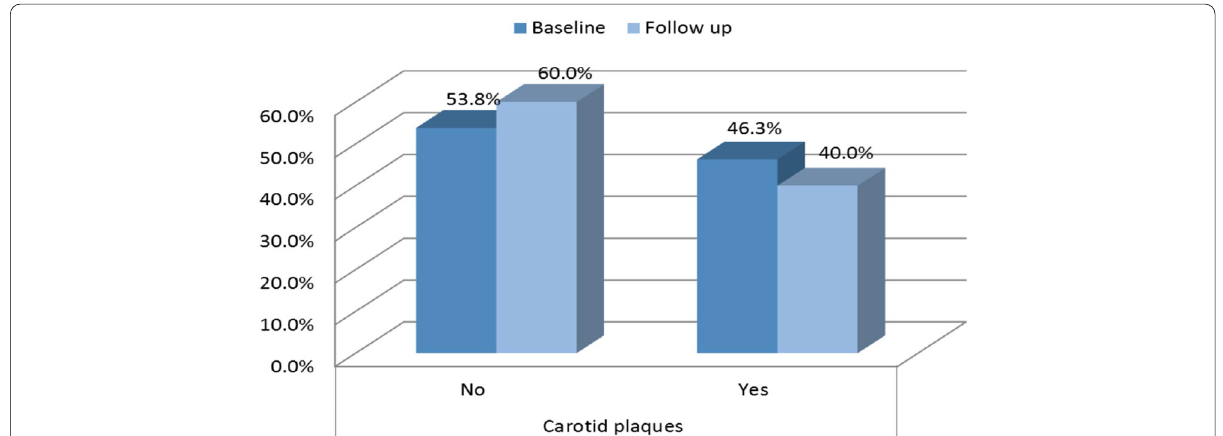
Fig. 2 Comparison between carotid plaques at baseline and follow-up. There was no statistically significant difference between the presence of carotid plaques before and after treatment, p 0.063 =